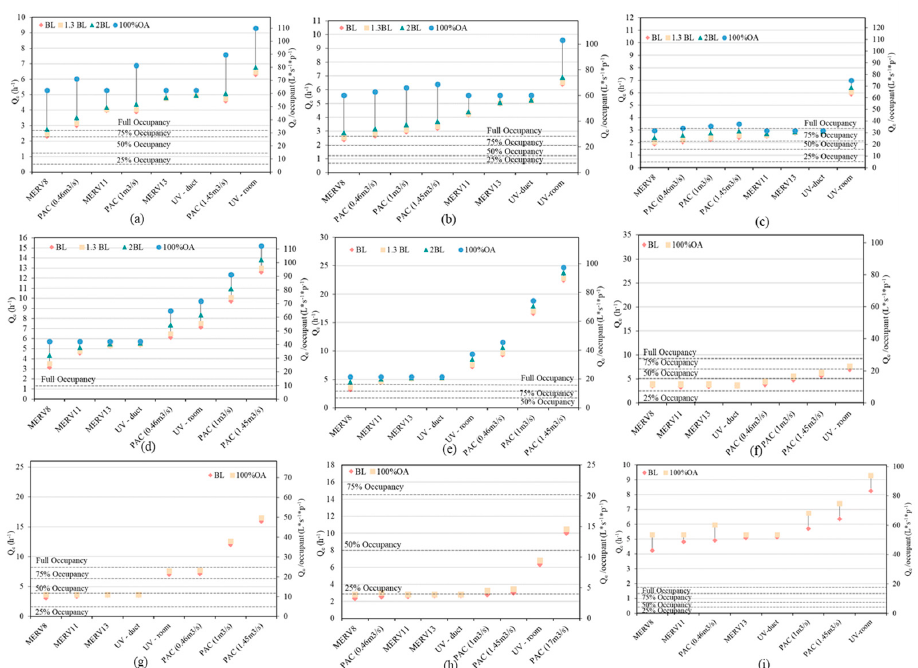
Figure 18. Minimum Q e for different mitigations with mark-wearing: ( a ) Medium Office—Core zone, ( b ) Large Office—Core zone, ( c ) Stand Alone Retail—Core Retail, ( d ) Small Hotel—Front Lounge, ( e ) Small Hotel—Meeting Room, ( f ) Secondary School—Classroom, ( g ) Secondary School—Corner Classroom, ( h ) Secondary School—Auditorium, ( i ) Secondary School—Cafe.